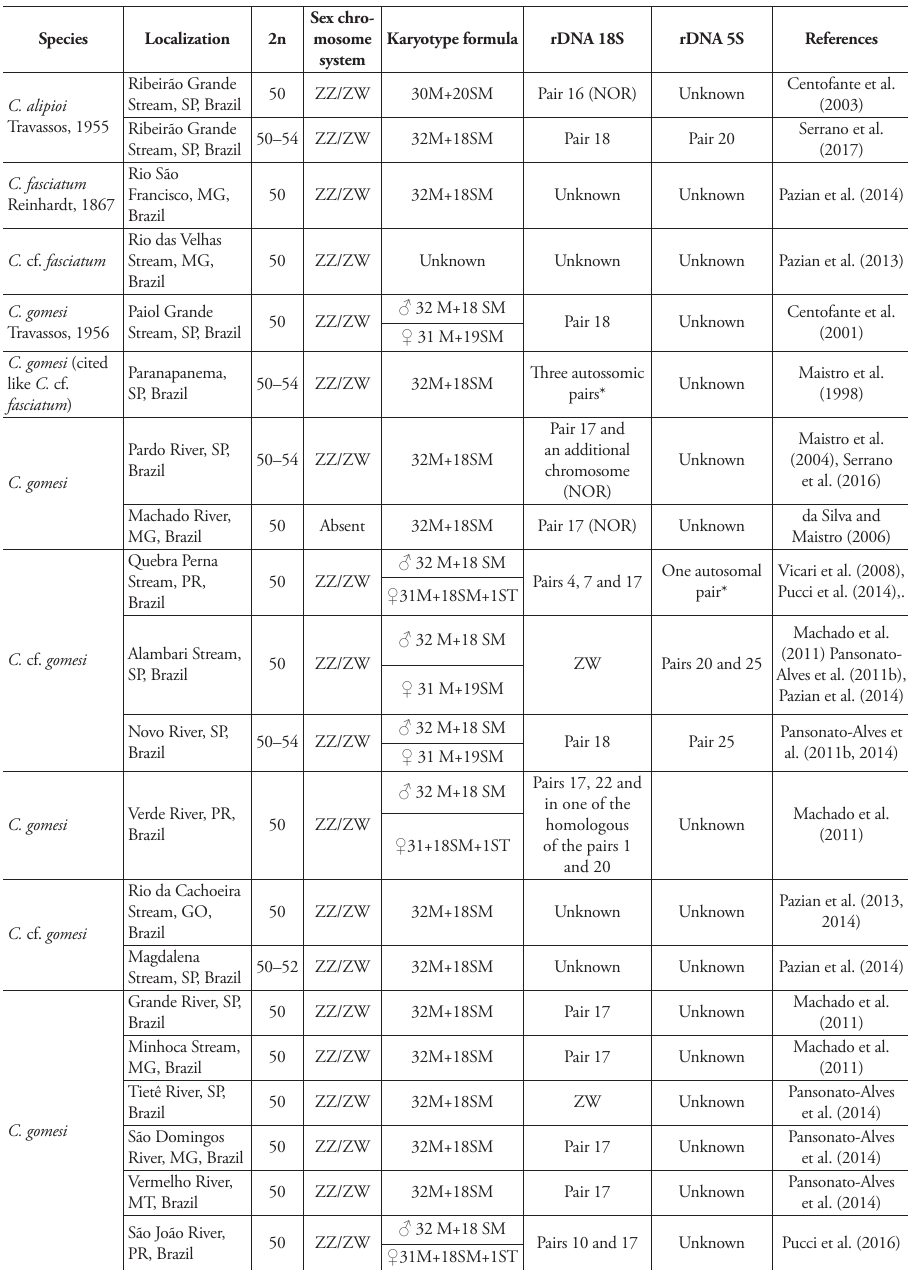
Table 1. Review of Characidium cytogenetic studies until 2018. The variation in the diploid number (2n) is due to the presence of B chromosomes. “Unknown” signifies that the data was not available in the origi- nal study. NOR: Nucleolar Organizer Region; M: Metacentric; SM: Submetacentric; ST: Subtelocentric; A: Acrocentric. * The chromosome pairs are not indicated in the original